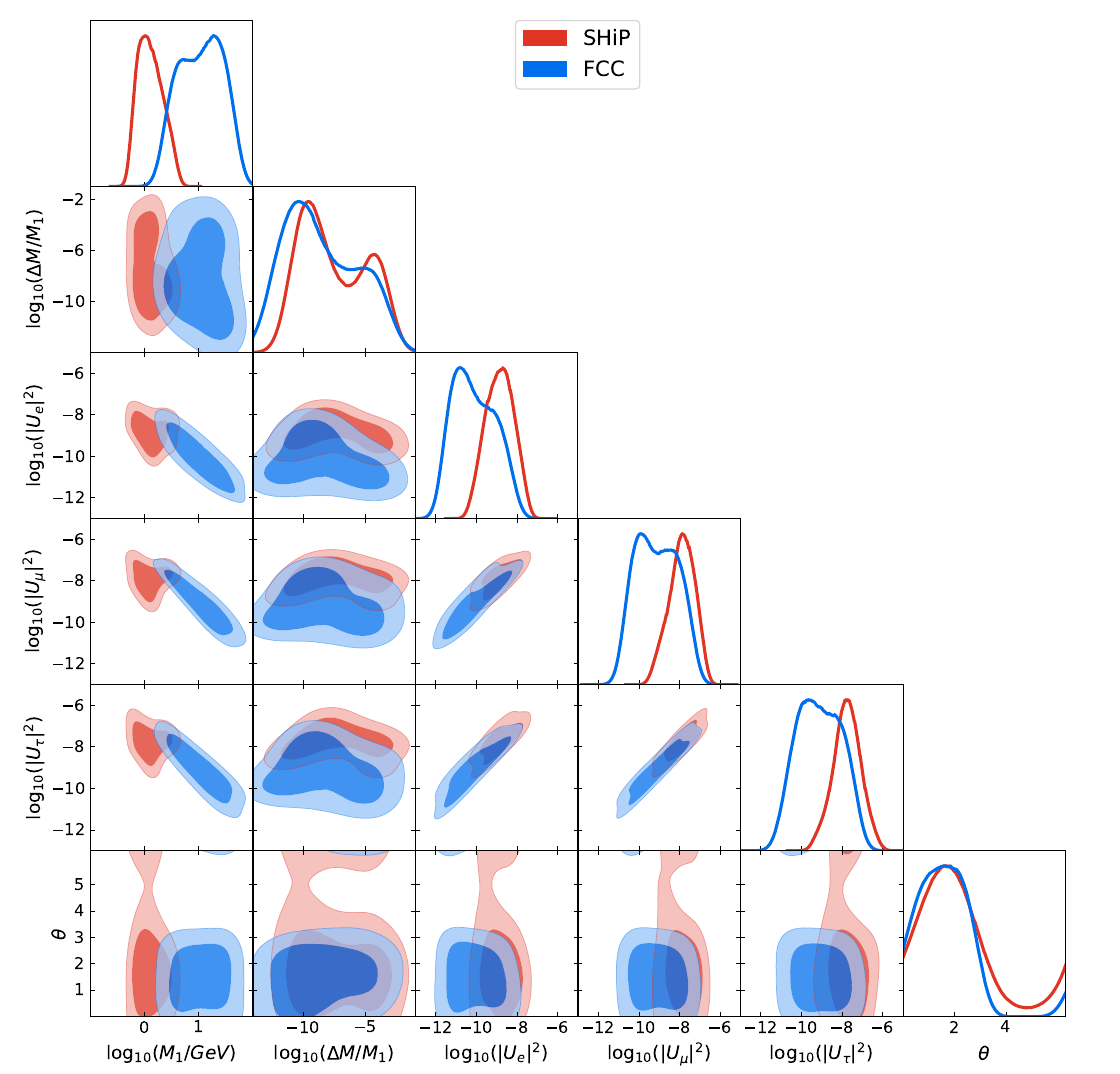
Figure 19 . Two-dimensional 1 and 2 σ posterior probability projections of the global numerical scan for NH, with priors given in table 3. The scan is performed separately for SHiP (red) and FCC (blue).